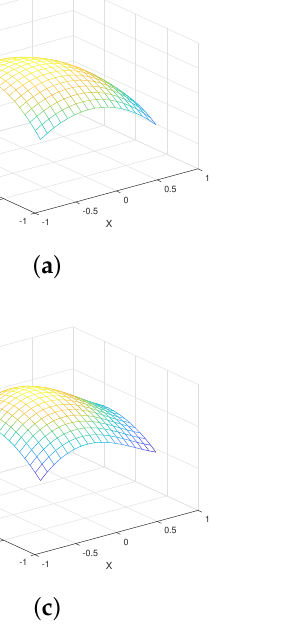
Figure 10. ( a ) A generated phase screen. ( b ) FSM-DM cascaded architecture approaching the generated phase screen. ( c ) Single DM architecture approaching the generated phase